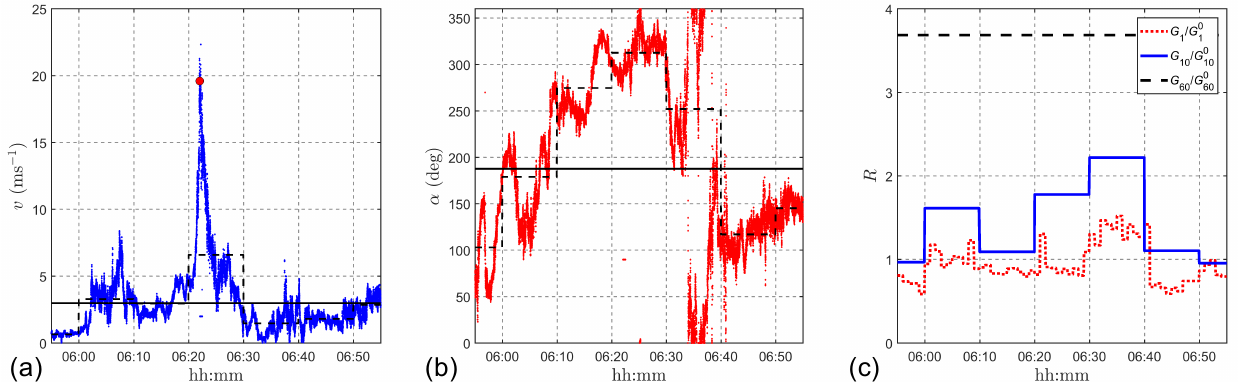
Figure 6. Thunderstorm outflow recorded on 25 June 2014 by the anemometer 3 of the port of La Spezia: (a) 1h wind speed time-series; (b) wind direction time-series; and (c) ratio of gust factors.